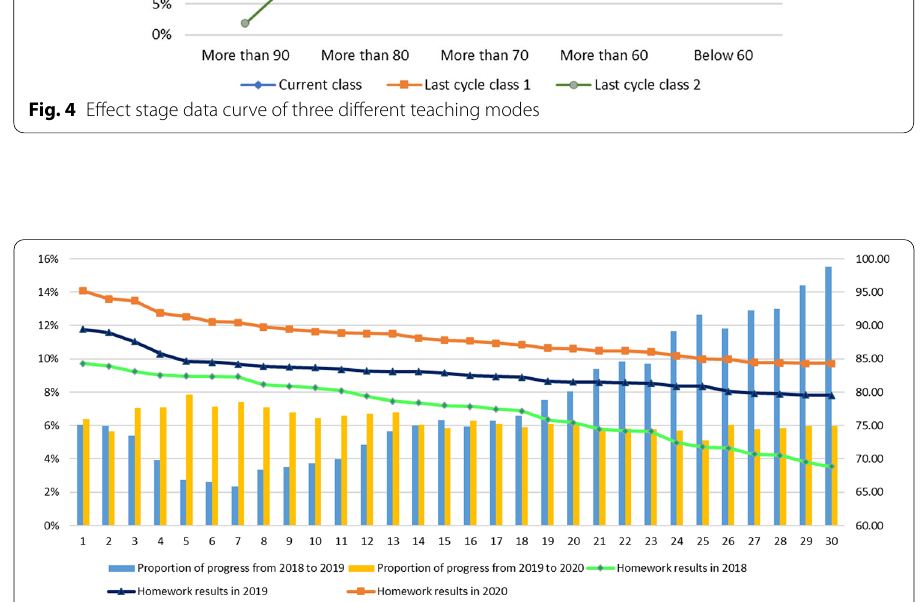
Fig. 5 From 2018 to 2020: comparative results of online and offline mixed teaching